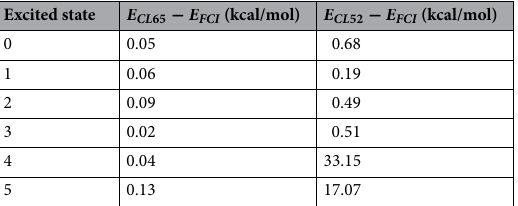
Table 1. Approximate ground and excited states energies for H 2 O in the sto-3g